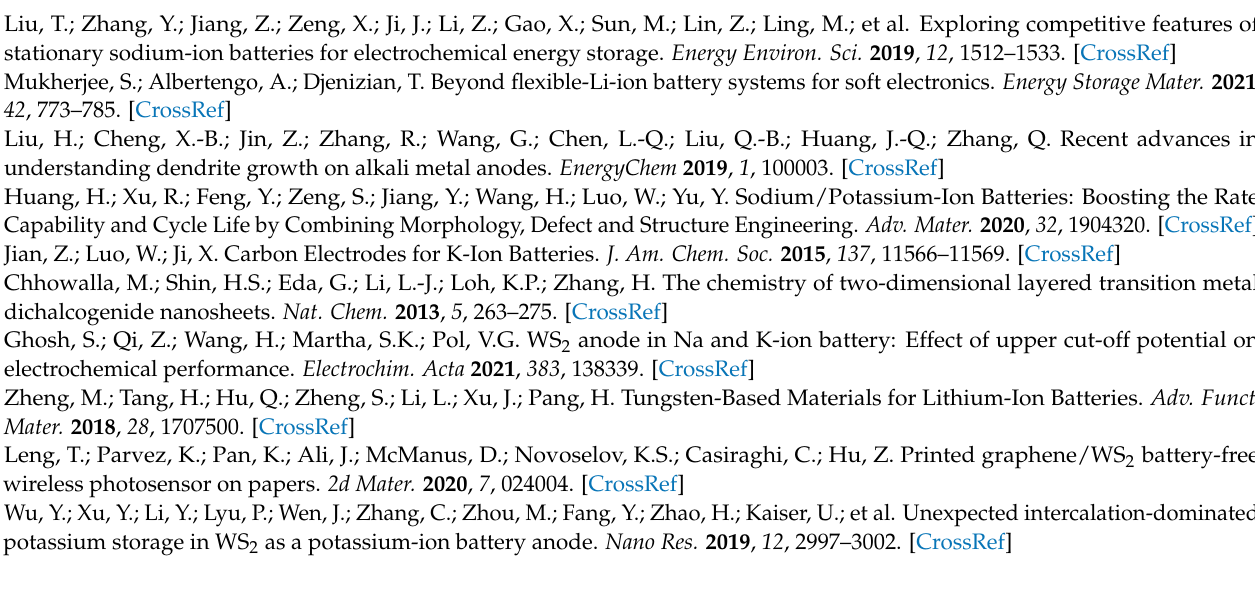
Table S1: Elemental composition obtained from the XPS survey scan; Figure S2: GCD profile and differential capacity curves of the WS 2 powder electrodes and SiOC fiber electrodes in NIB setup; Figure S3: GCD profile and differential capacity curves of the WS 2 powder electrodes and SiOC fiber electrodes in KIB setup; Table S2: Summary and comparison of electrochemical performance for Na + ion storage of other nanomaterial-based structures with this work; Table S3: Summary and comparison of electrochemical performance for K + ion storage of other nanomaterial-based structures with this work. References [5,10,15,26,56–74] were cited in the Supplementary Materials. Author Contributions: Conceptualization: G.S.; methodology: G.S. and S.D.; analysis: S.D.;